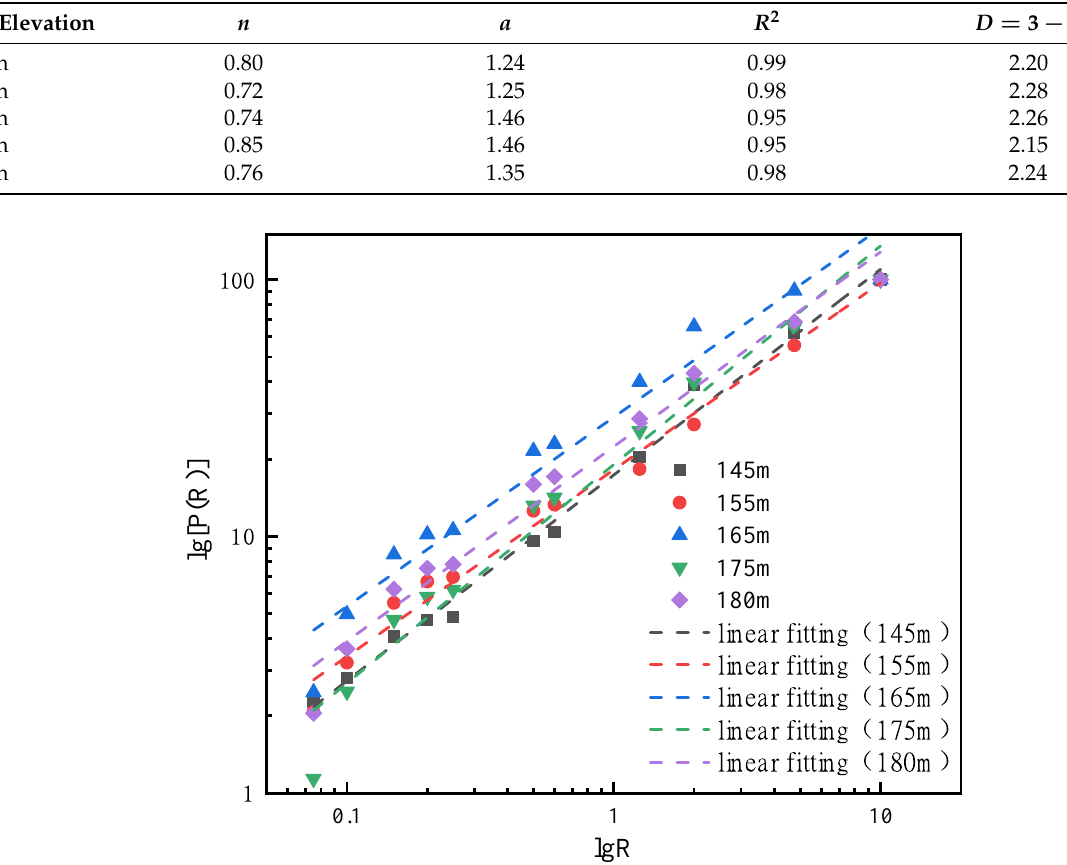
Figure 4. Fractal curves of soil with different